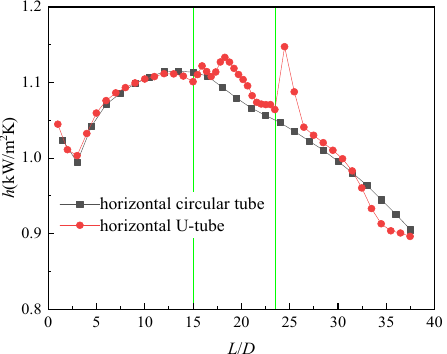
Figure 13. The changes in Nu with L / D in the horizontal U ‐ tube and the horizontal straight tube.